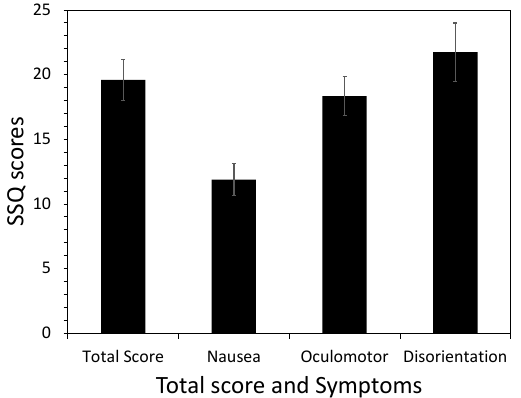
Figure 5. Mean of the SSQ scores for the difference between pre- and post-exposure. The error bar represents a 95% confidence interval.